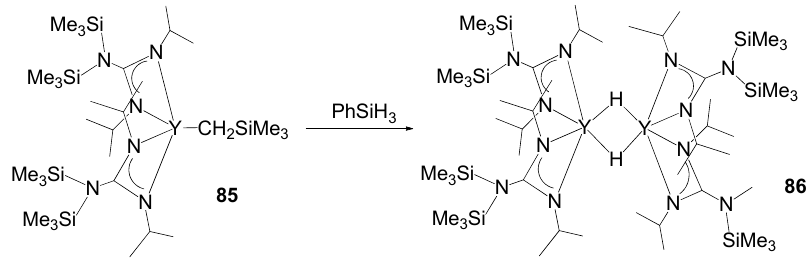
Figure 51. Synthesis of an yttrium hydride stabilized by guanidinato ligands.